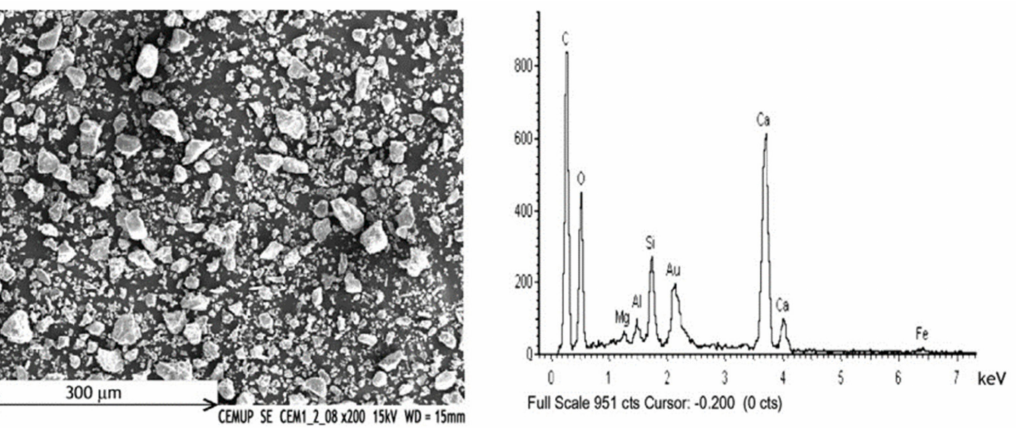
Figure 5. SEM micrograph and EDX analysis of waste wood ash (used with permission from Elsevier